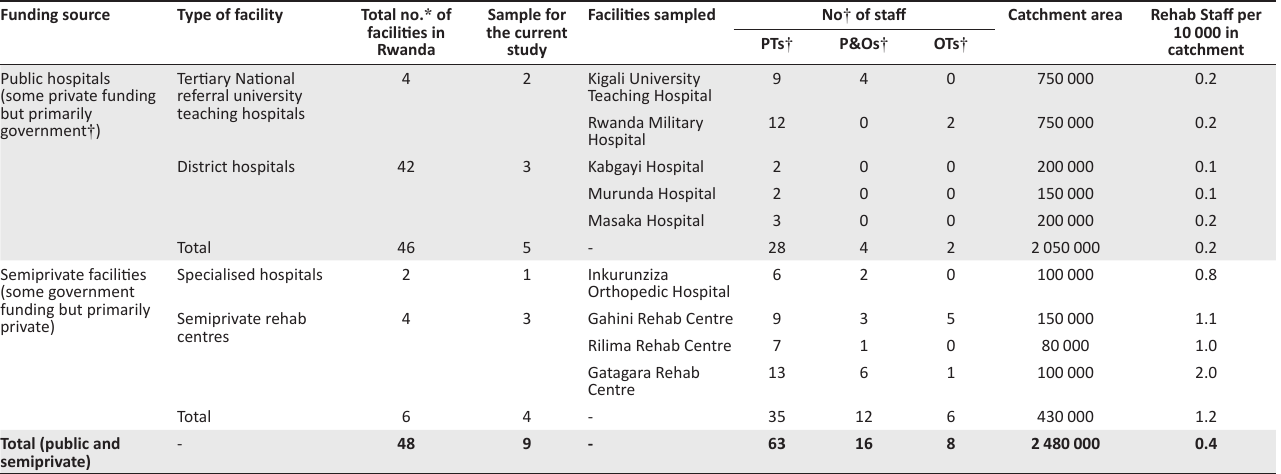
TABLE 1a: Distribution of rehabilitation services by funding source and type of health facility. Funding source